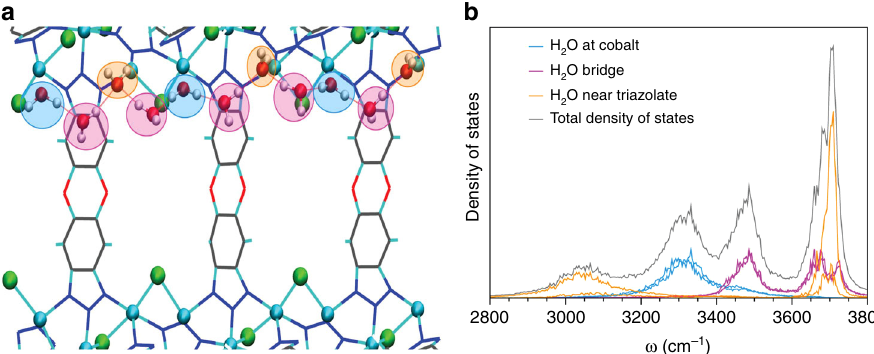
Fig. 4 Chains of Water Bridge Between Cobalt Sites. a Structure of the one-dimensional water chain with water at cobalt (blue), water bridges (pink), and water near the triazolate (orange) highlighted. Distance shown along the z- axis is 24 Å. b Density of states calculated for individual hydrogen